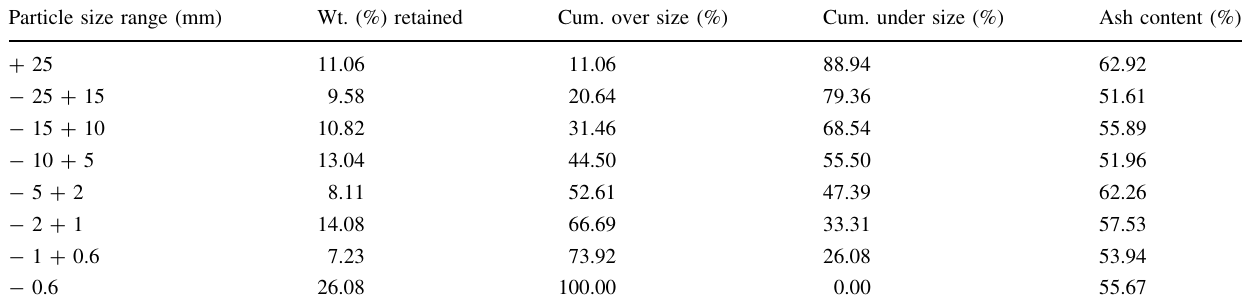
Table 1 Particle size analysis of samples from the tailing dam Particle size range (mm)